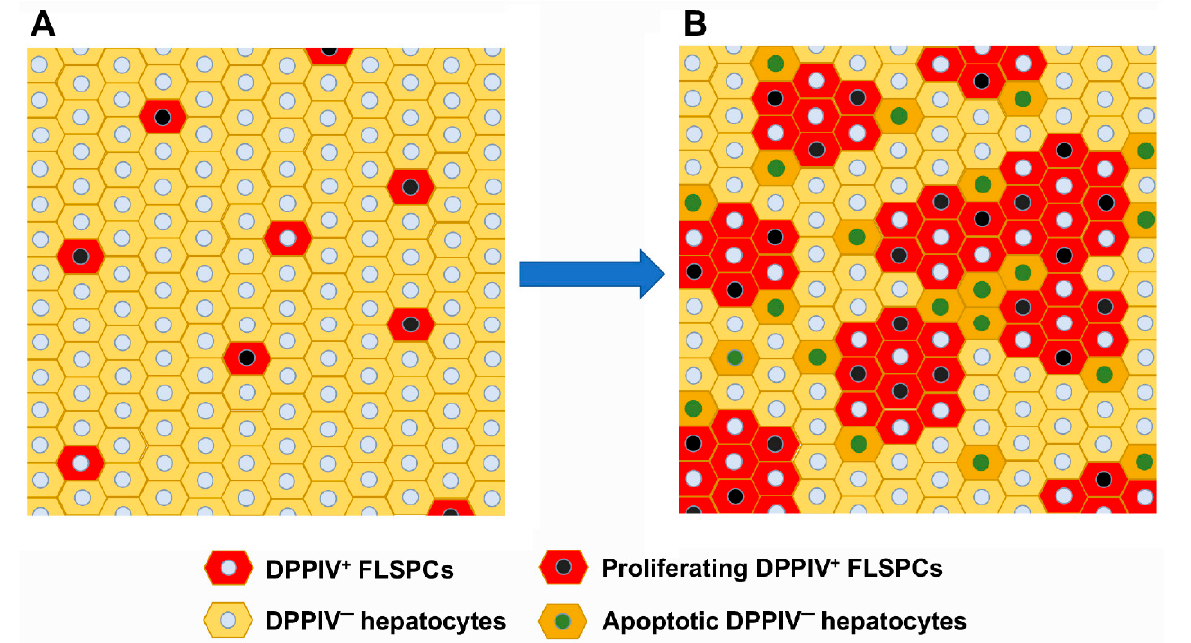
Figure 1. Repopulation via cell competition by transplanted DPPIV + FLSPCs into DPPIV − host liver: ( A ) Engrafted, highly proliferative fetal liver cells. ( B ) Dividing FLSPCs form cell clusters and induce apoptosis in host parenchyma cells.